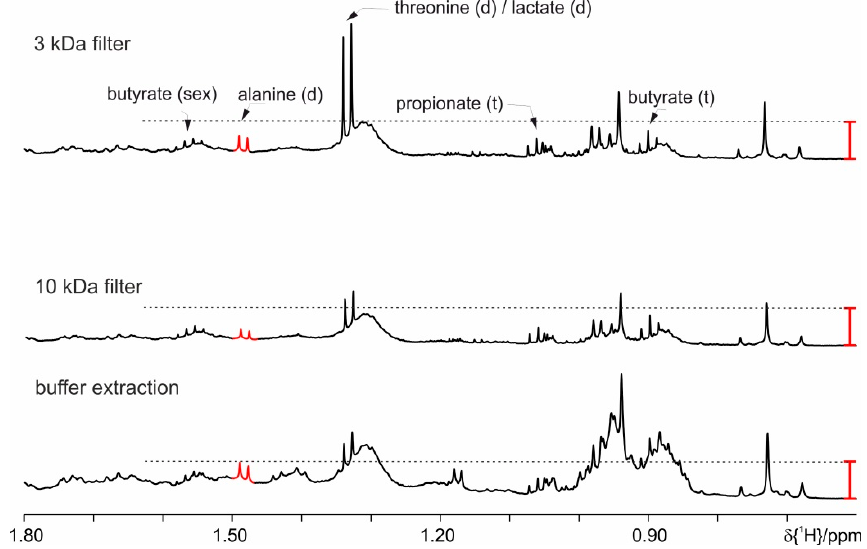
Figure 12. Proton spectra of feces extraction from mice fed on study diet (HFD) demonstrating the effect of the use of cut off filters (3 kDa and 10 kDa filter) to separate the high molecular weight components. As comparison, a spectrum obtained with the basic protocol is shown. The red bar indicates the differences in the signal intensities.